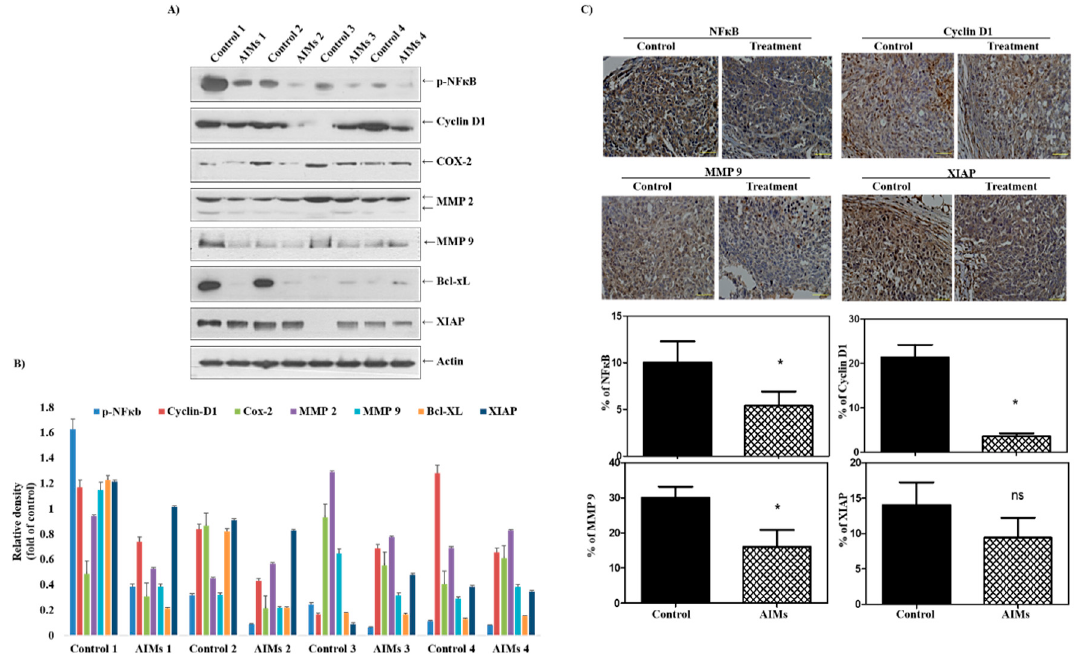
Figure 3. Reduction in NF- κ B activation with the treatment of AIMs. ( A ) The NF- κ B activation has been reduced with the treatment of AIMs. Western blot analysis of the tumor xenograft models using antibodies against NF- κ B and various NF- κ B-regulated proteins involved in cancer cell proliferation (cyclin D1 and COX-2), invasion, and migration (MMP-2 and MMP-9) and anti-apoptosis (Bcl-xL). ( B ) Densitometry analysis of Western blot bands. The values were normalized against β -actin. ( C ) The immunohistochemical analysis of NF- κ B, proliferation (cyclin D1), and invasion (MMP-9) revealed that AIMs suppressed the nuclear activity of NF- κ B and the expression of proliferation and invasion. The data are shown as the means ± SD of three independent experiments, * p < 0.05 between the treated and the untreated control group.